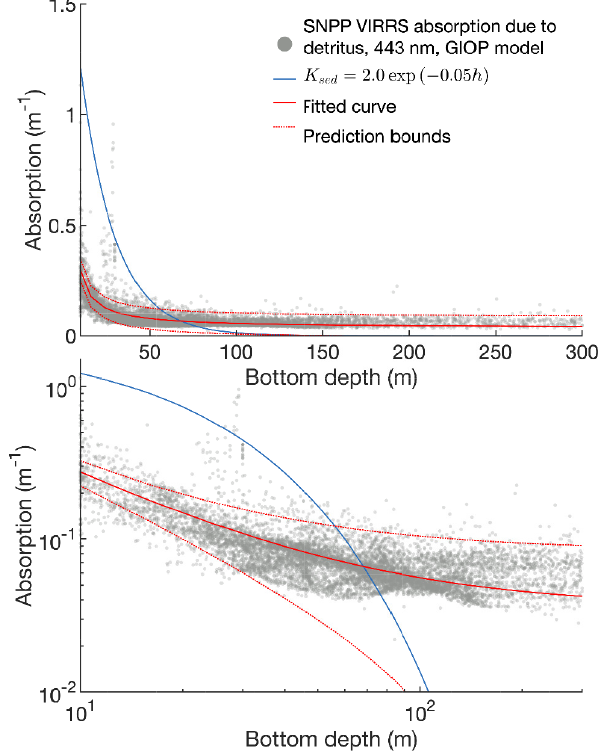
Figure B2. Attenuation due to sediment derives from a power law fit of satellite estimations of absorption due to gelbstoff and detrital material (entire mission composite from VIIRS, 2012–2018) versus bottom depth. Subpanels show the same data in linear and logarithmic